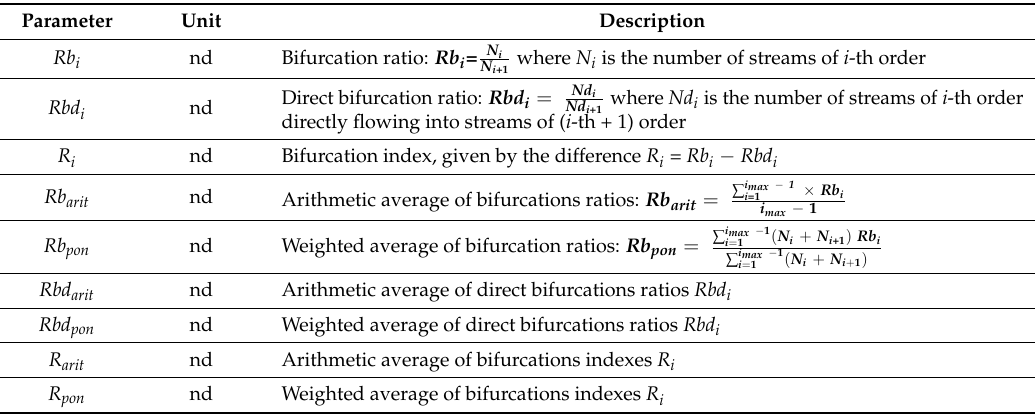
Table A2. Parameters describing the topological organization of river